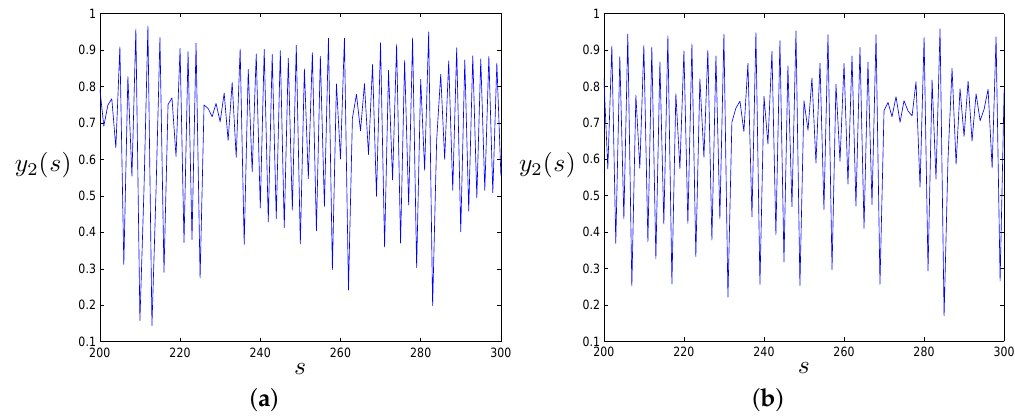
Figure 2. Chaotic trajectory. ( a ) The CML chaotic system; ( b ) the NCML chaotic system.